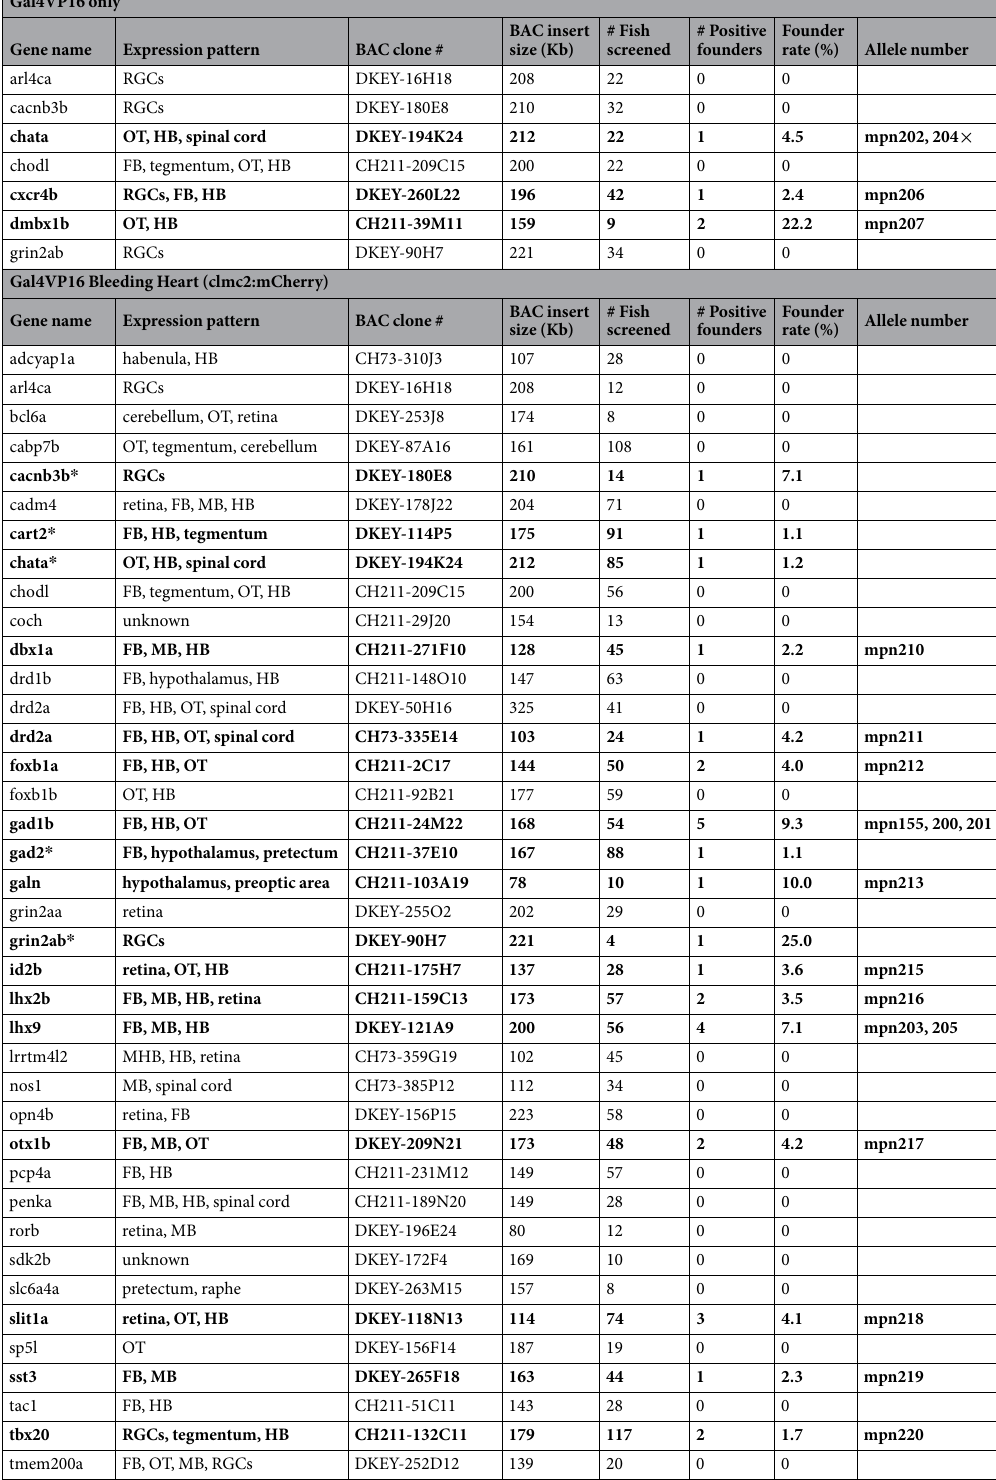
Table 1. List of Gal4VP16 and Gal4VP16-Bleeding Heart constructs and transgenic lines. Seven Gal4VP16 and 39 Gal4VP16-Bleeding Heart BAC constructs that were generated and validated to express Gal4VP16 after transient injection. Founder rate is defined as a percentage of germline founders out of total adult fish screened. Bold texts indicate the constructs from which Gal4VP16-expressing transgenic line(s) were isolated. FB, forebrain; MB, midbrain; HB, hindbrain; RGCs, retinal ganglion cells; OT, optic tectum; * lines discontinued; × second line identified in an additional round of